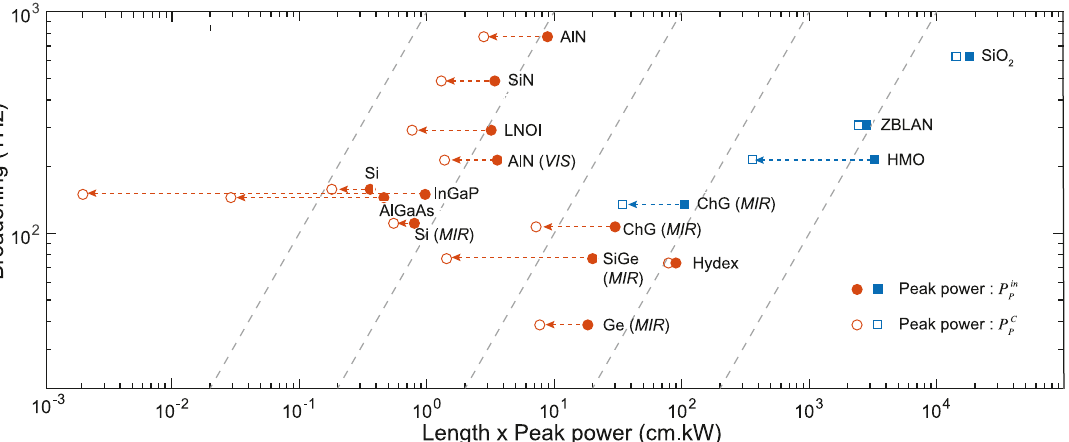
Figure 6: FOM and performance comparison. Spectral broadening (in THz) as a function of the product length × peak power. The squares are fiber platforms while the circles are integrated platforms. Full markers are calculated based on the estimated peak power at the input waveguide while the open markers are for the coupled peak power pumping band is indicated: it can be in the near visible (VIS) around 780 nm or in the middle infrared (MIR) between 3 and 8 μ m. Dashed lines are indication of constant FOM from 0.1 to 1000 (right to